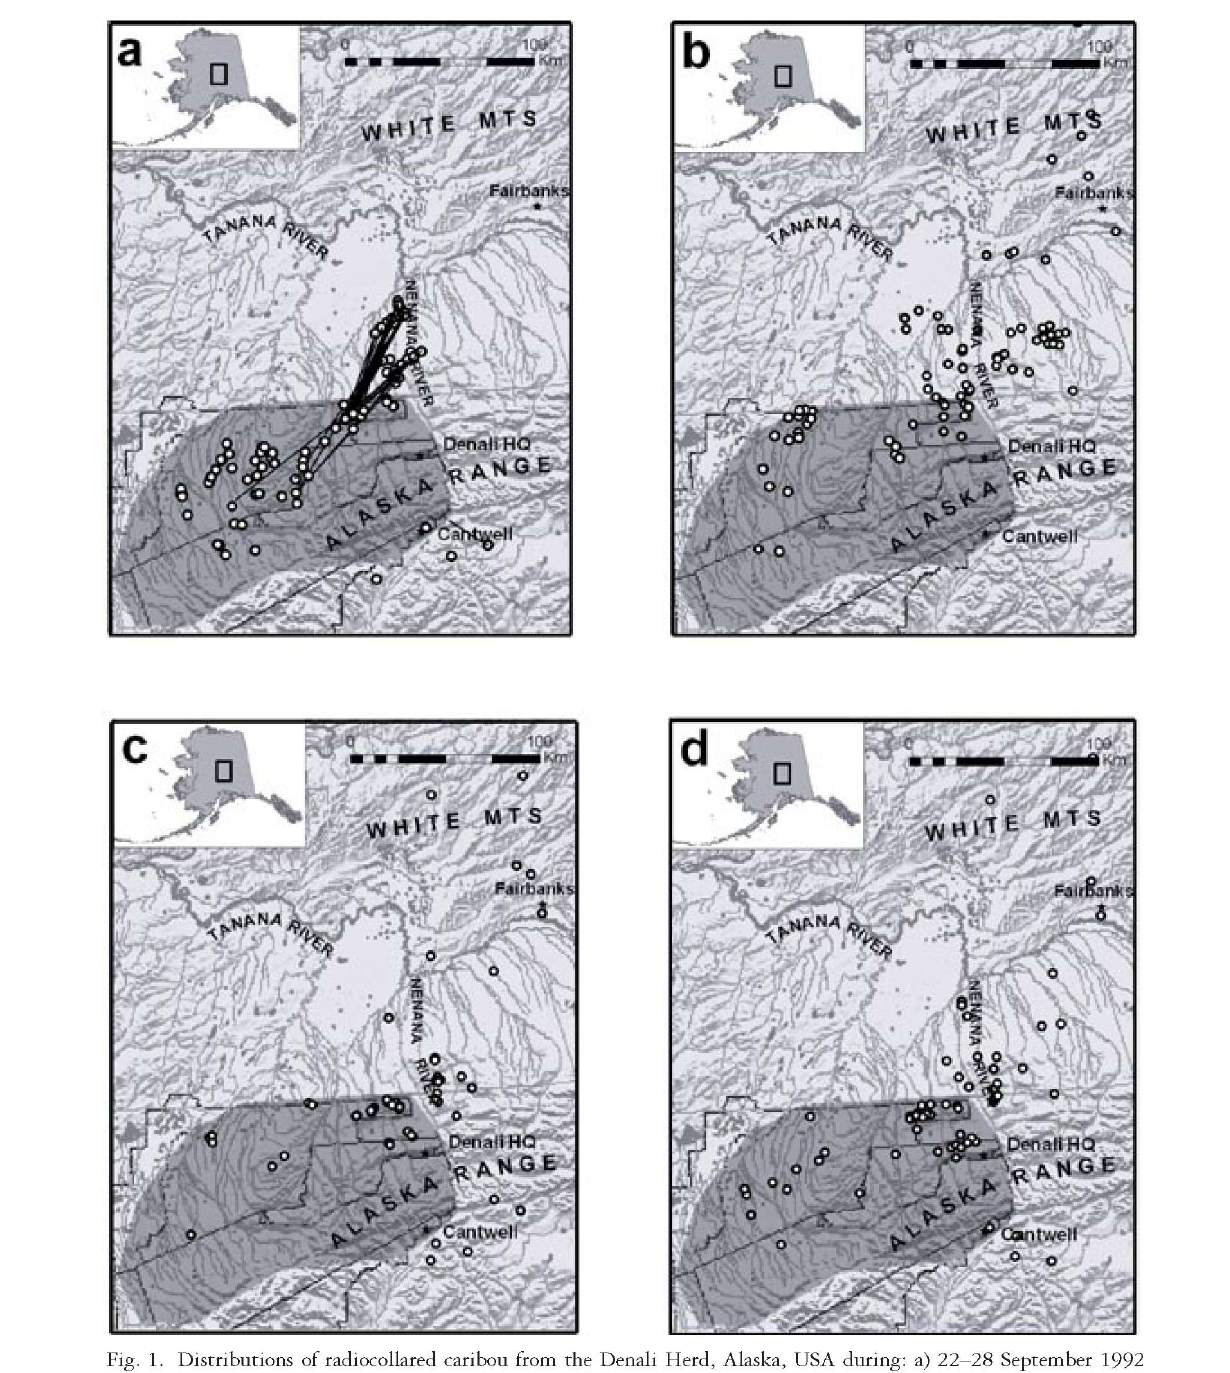
Fig. 1. Distributions of radiocollared caribou from the Denali Herd, Alaska, USA during: a) 22—28 September 1992 (lines indicate movements of caribou from 22—24 September to 26—28 September); b) 2—5 November 1992; c) 8—12 February 1993; and d) 12—22 March 1993. Shading indicates typical herd range.